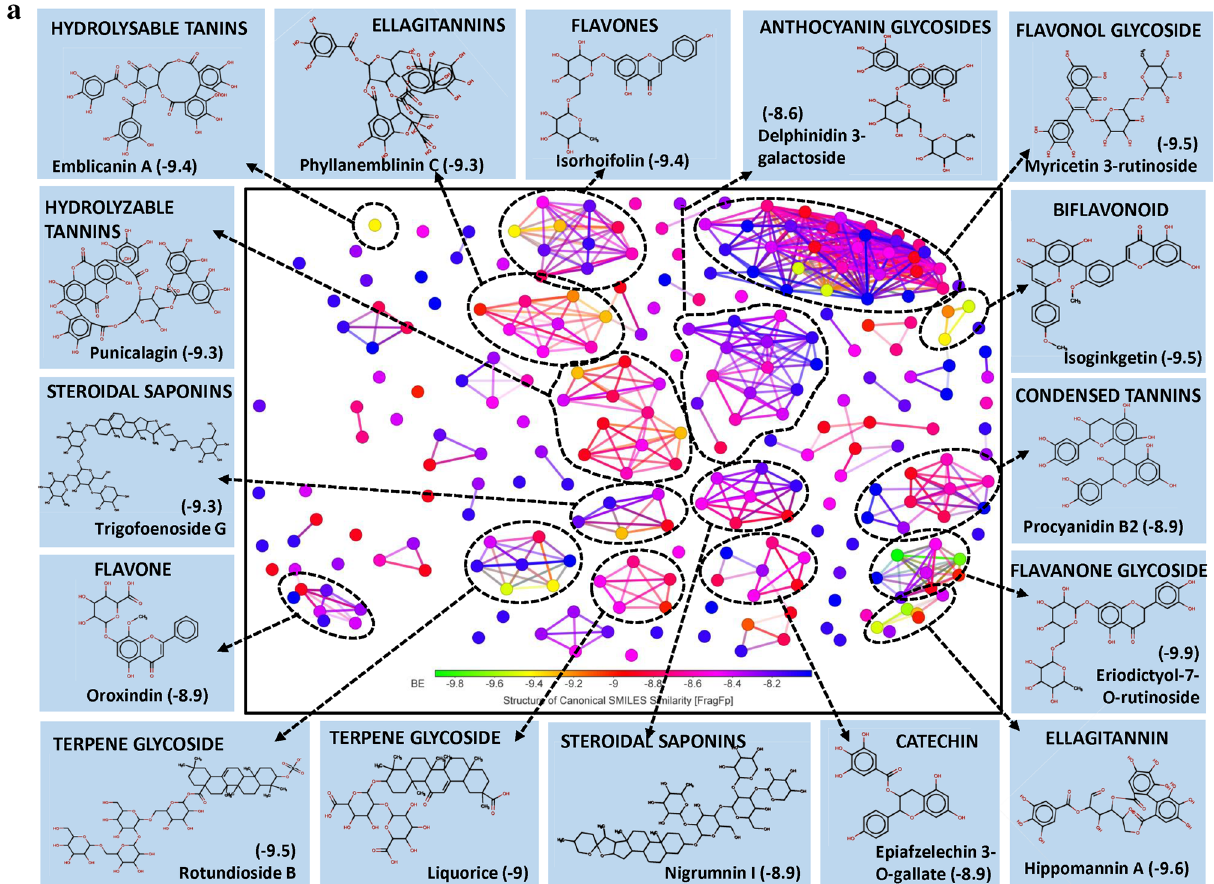
Figure 4. ( a ) Structural activity relationship: Correlation of canonical SMILES structure similarity (data points are joined by colored lines) and binding energy (represented in different color shades of data point) of selected plant secondary metabolites (PSM) evaluated against SARS-CoV-2 RdRp using Data Warrior software. Structurally similar molecules are grouped in dotted lines and a representative molecule with low binding energy (kcal/mol) (values in parenthesis) is represented in box. Here, large number of falvonol glycoside (> 13%) followed by hydrolysable tannins, anthocyanins and triterpenes are the major group of PSM found interacting with target site of SARS-CoV-2 RdRp. ( b ) Data analysis of selected PSM against SARS-CoV-2 RdRp. ( A ) Bioavailability radar chart representing lipophilicity (LIPO), Molecular weight (SIZE), Topological polar surface area (POLAR), Solubility (INSOLU), Flexibility (FLEX) and Saturation (INSATU) along with Bioavailability score (BAS) of selected molecules, ( B ) 3D visualization of protein–ligand interaction using PyMOL (selected amino acid residue of target site of protein are colored in cyan, and ( C ) 2D visualization of different types of interactions between ligand and target site of protein using Discovery Studio software (different types of interactions are represented in color